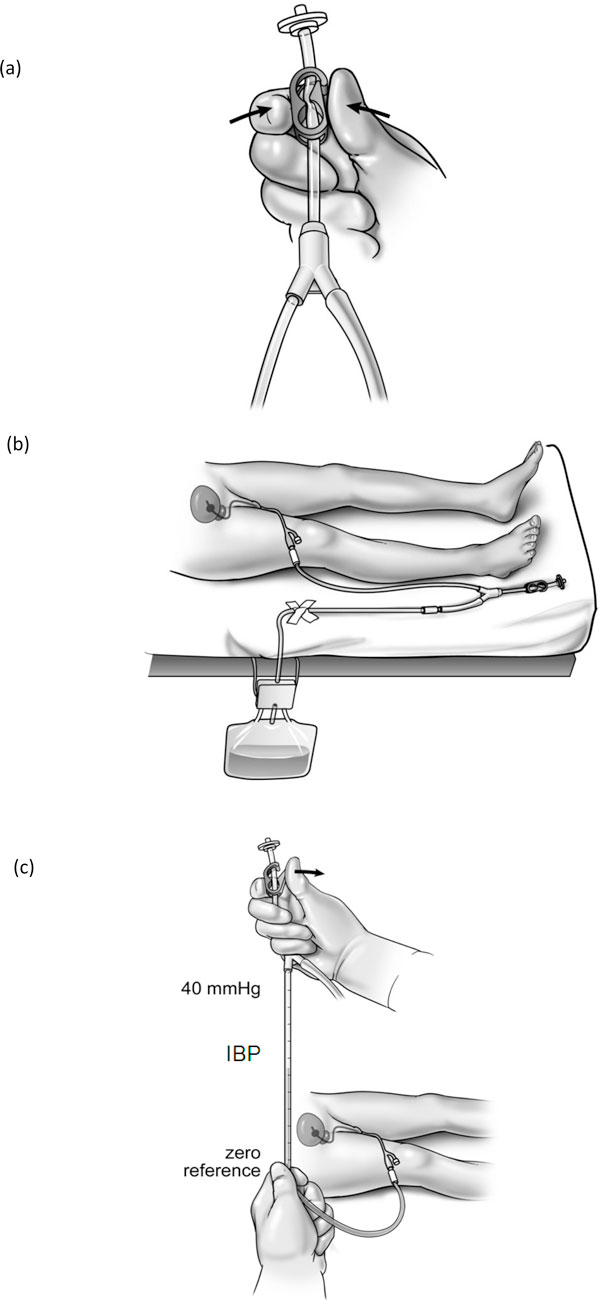
Intrabladder pressure monitoring with the FoleyManometerLV. This technique that uses the patient's own urine as pressure transmitting medium is a simple, reliable, and cost-effective clinical tool. Based on a modified version of the IAP monitoring technique described by Malbrain [3], the disposable FoleyManometer provides a closed sterile circuit which connects between the patient's Foley catheter and the urine collection device. Each IAP determination takes about 10 s, and no subsequent correction of urine output is required. The technique uses a low bladder infusion volume, has a needle-free sampling port, and can measure IAP in a range from 0 to 40 mmHg. A Initial setup: - Open the FoleyManometer LV pouch and close the tube clamp. - Place the urine collection device under the patient's bladder and tape the drainage tube to the bed sheet. - Insert the FoleyManometer between catheter and drainage device. - Prime the FoleyManometer with 20 ml of sterile saline through its needle-free injection/sampling port. - Prime only once at initial setup B Urine drainage: - Let the urine drain in between IBP measurements. - Urine sampling from the needle-free port is facilitated by temporarily opening the red clamp. Remember to close clamp afterward. - Avoid a U-bend of the large urimeter drainage tube (which will impede urine drainage). - Replace the FoleyManometer whenever the Foley catheter or the urine collection device is replaced, or at least every 7 days. C Intravesical pressure monitoring: - Place the '0-mmHg' mark of the manometer tube at the midaxillary line at the level of the iliac crest (mark for future reference) and elevate the filter vertically above the patient. - Open the bio-filter clamp and read IBP (end-expiration value) when the meniscus has stabilized after about 10 s. - Close clamp after IBP measurement and place the FoleyManometer in its drainage position.